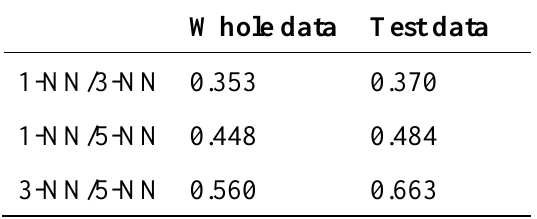
Table 5. Values of kappa statistics for the differences between given k-NN classifiers.